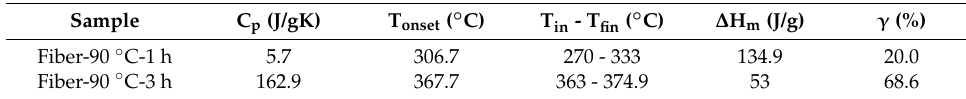
Table 3. Theoretical crosslinking index, γ ( %), of sulfonated HDPE/SKL (90:10) fibers according to thermal analysis.